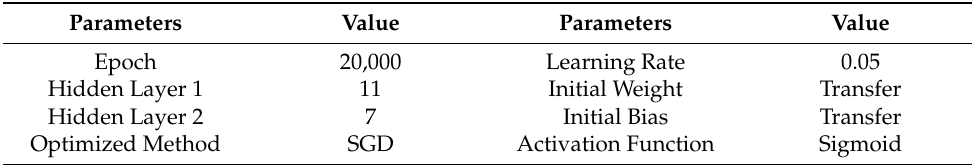
Table 20. Network hyperparameter settings